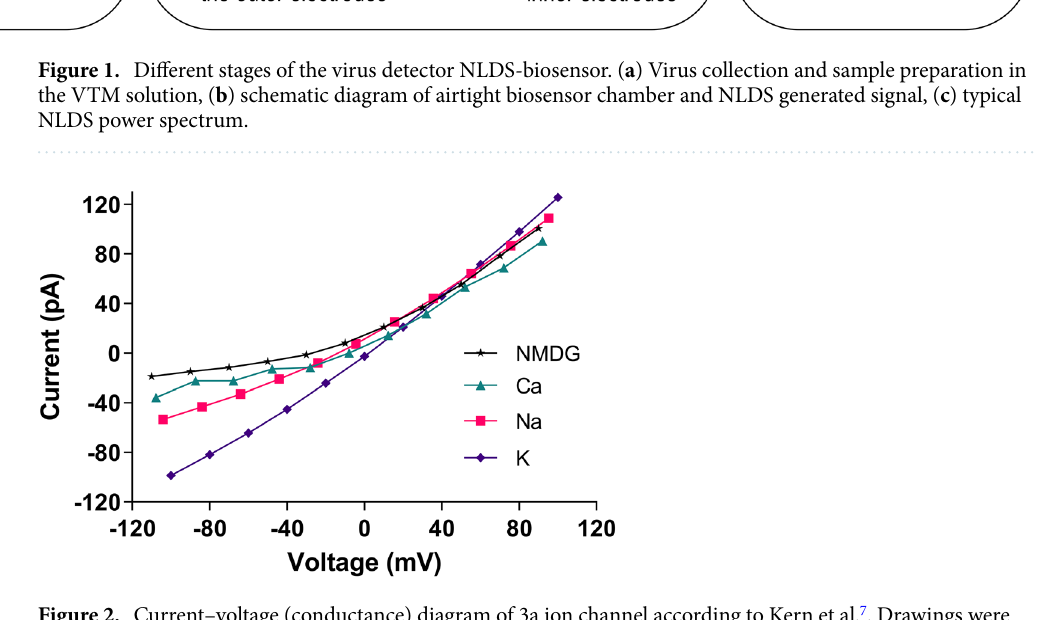
Figure 2. Current–voltage (conductance) diagram of 3a ion channel according to Kern et al. 7 . Drawings were made using Inkscape version 1.1 and GIMP version 2.10.28 (http:// www. gimp. org, http:// www. inksc ape.